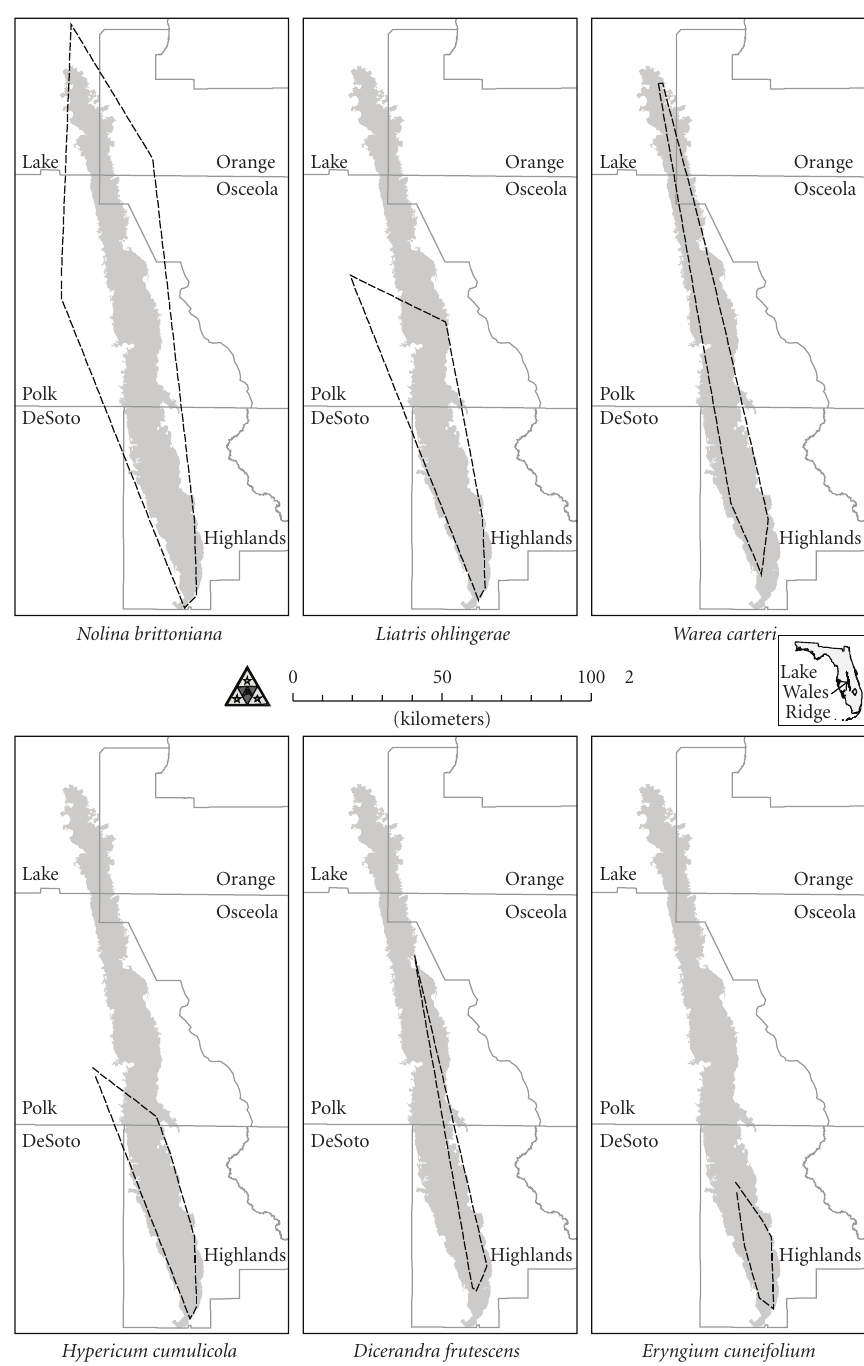
Figure 1: Minimum convex polygons for distributions of six study species on the Lake Wales Ridge in central